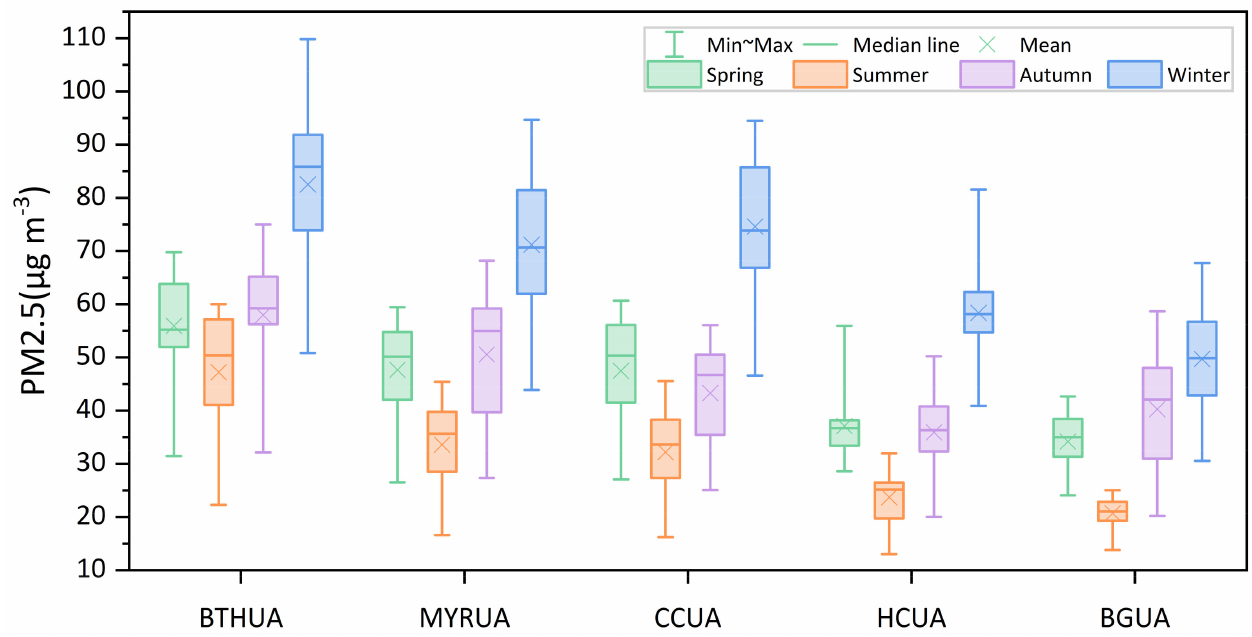
Figure 3. Seasonal variation of PM 2.5 concentrations in the five UAs over the period